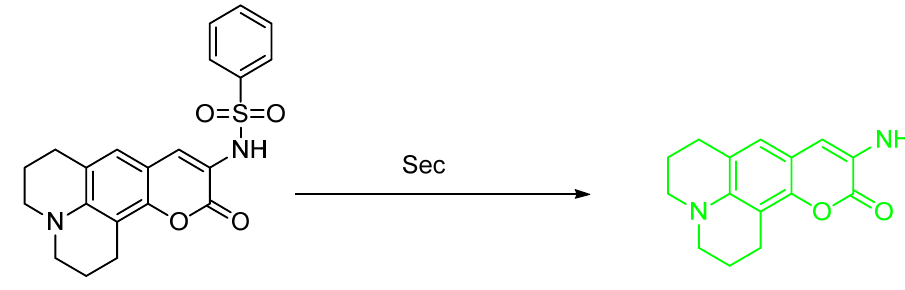
Figure 70. Structure of Probe 3 synthesized by Sun et al.